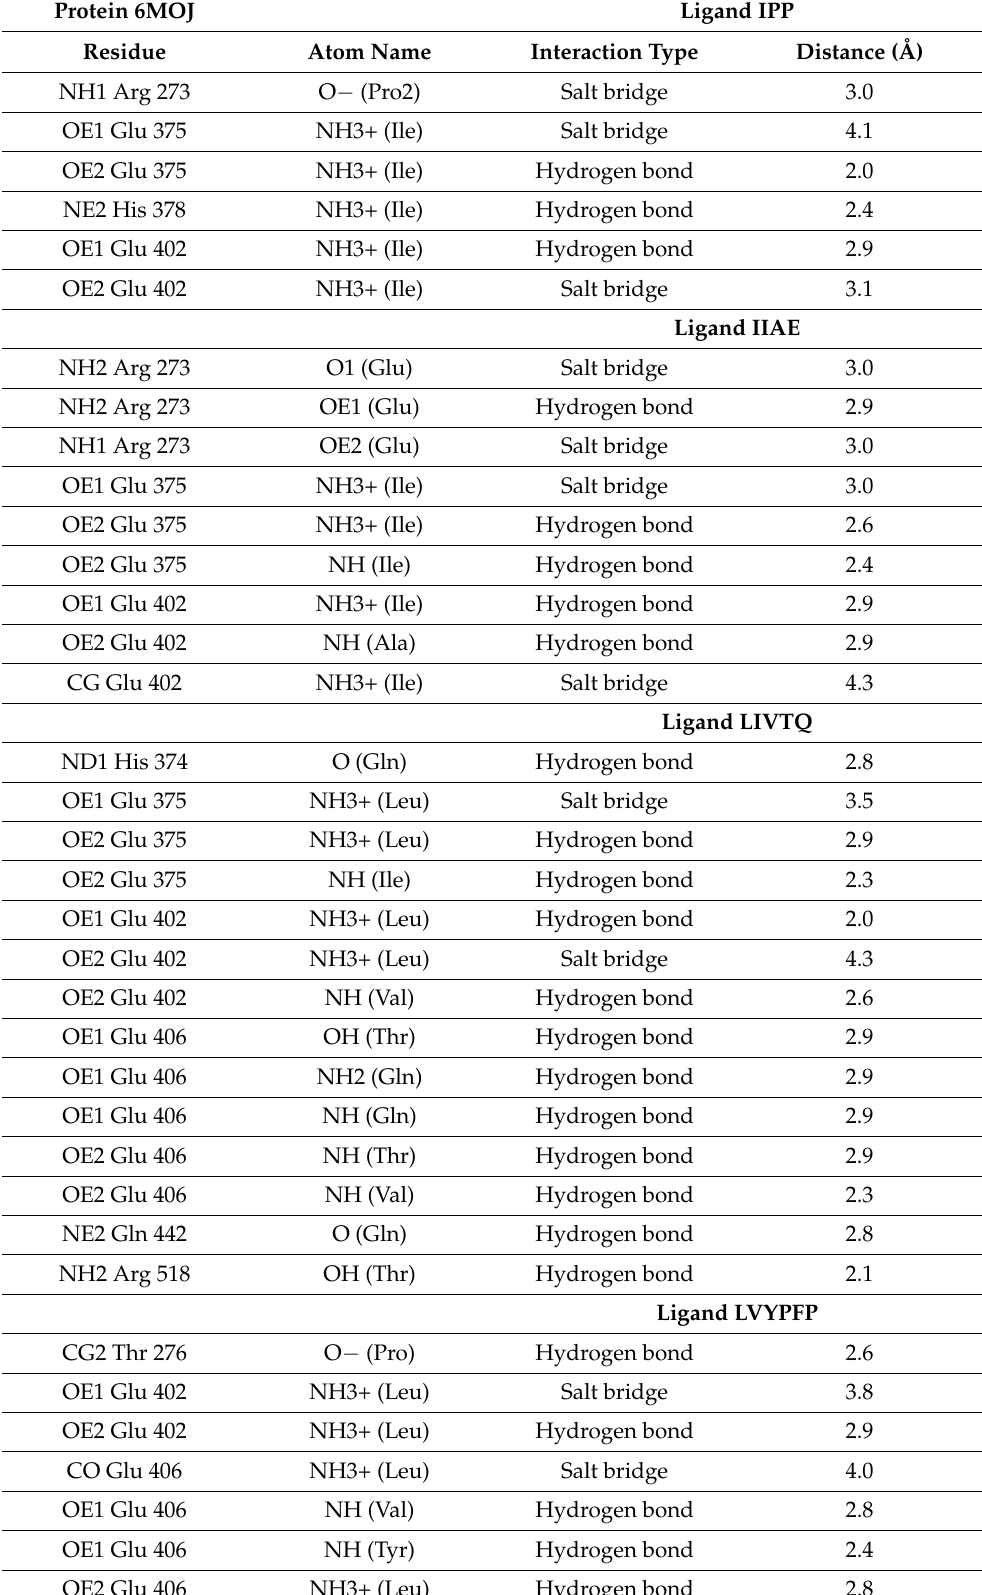
Table 1. Docking results of IPP, IIAE, LIVTQ, and